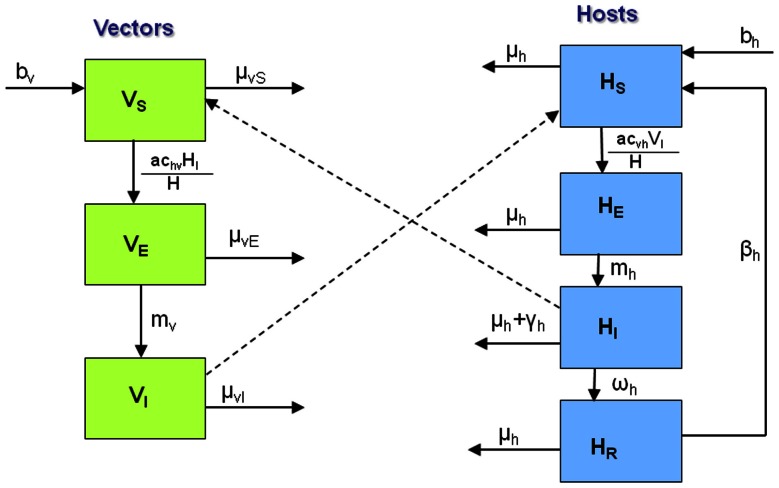
Basic structure of the malaria model.See Tables 1 and 2 for a summary of state variables and parameters.